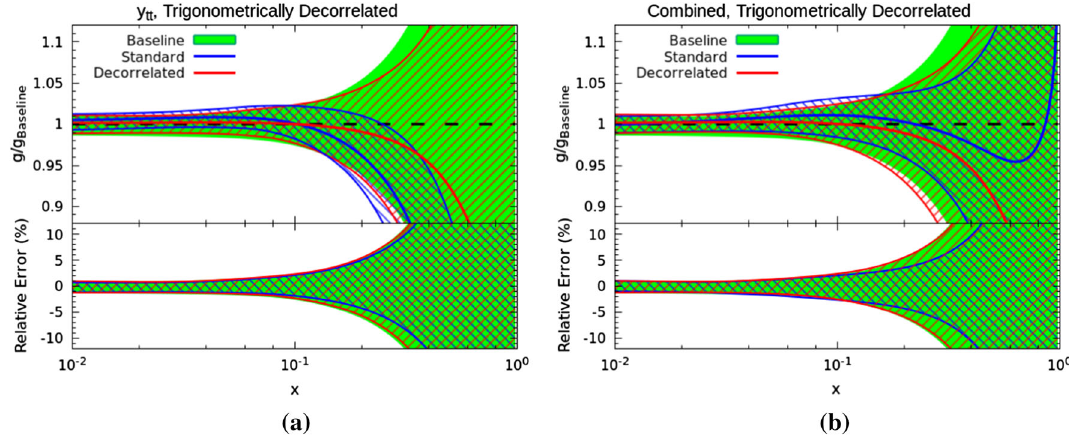
Fig. 6 Fits to the y tt distribution and all distributions together along with different decorrelation procedures along y tt , compared to fits with no decorrelation